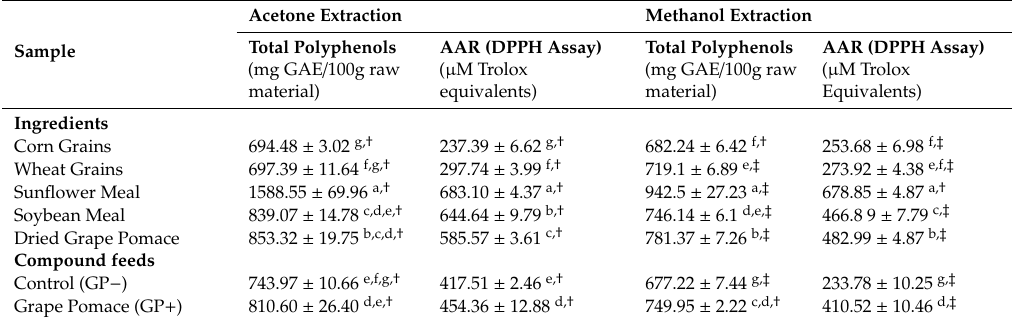
Table 2. Total polyphenols content and antiradical (antioxidant) activity (AAR) of the compound feeds and of their